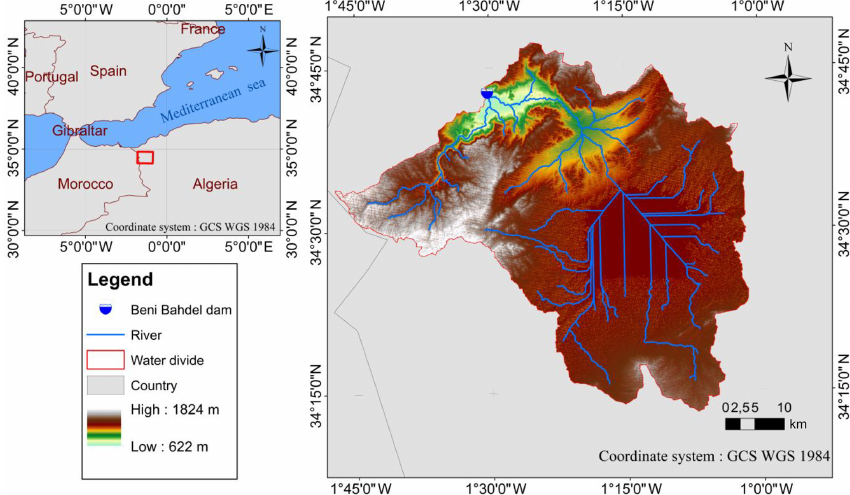
Figure 1. Location of the Beni Bahdel Dam catchment.